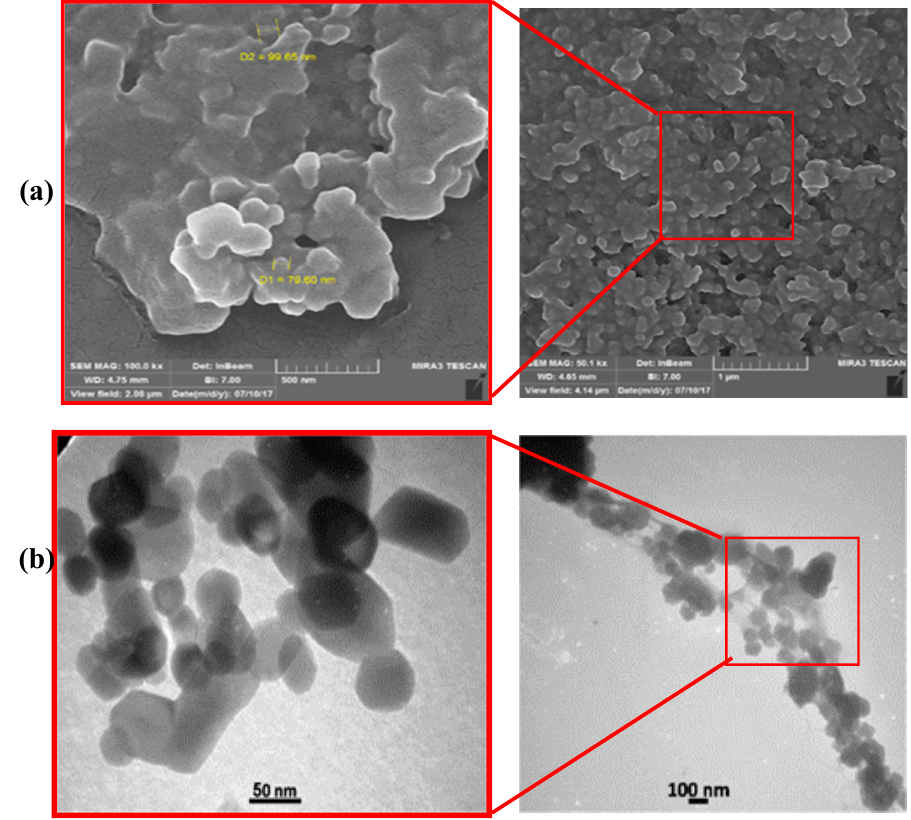
Figure 4. Field emission scanning electron microscopy (FESEM) analysis of synthesized iron nanoparticles at two different magnifications. ( a ) Transmission electron microscopy (TEM) micrograph of iron exposed by a mixture of extracts ( b ). Table 4. Size and morphology of Fe 0 /Fe 2 O 3 /Fe 3 O 4 nanoparticles synthesized by various plant extracts